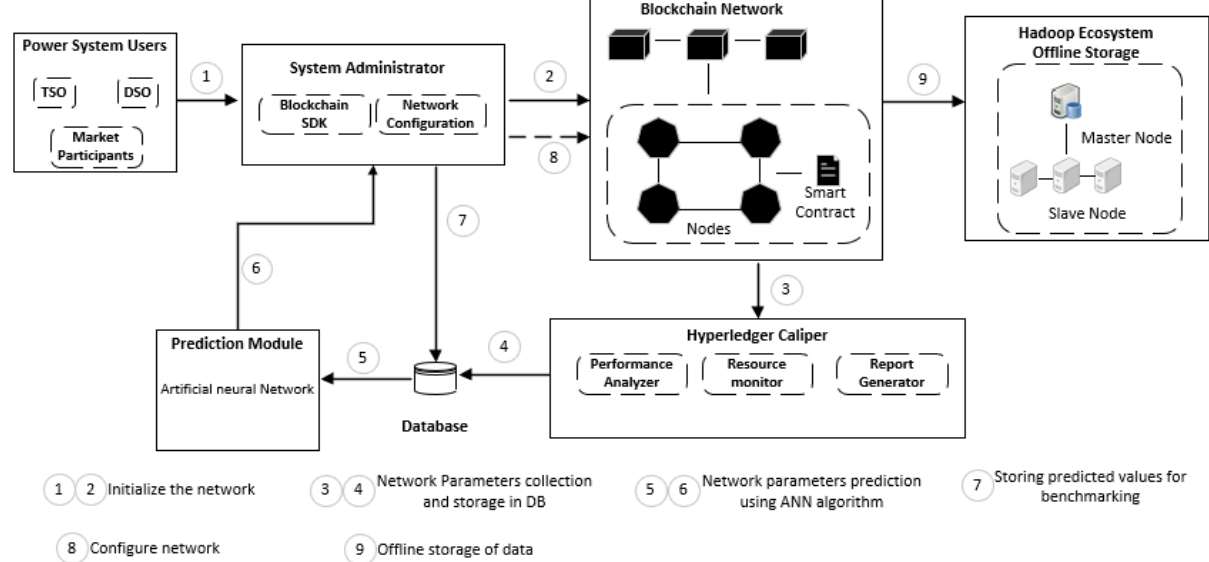
Figure 4. The architecture of the ANN-based performance optimization of blockchain.